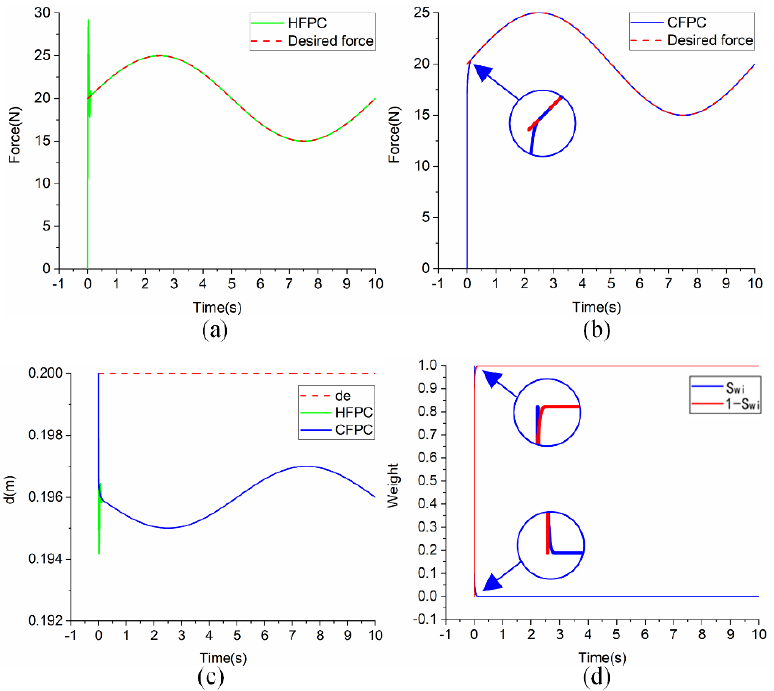
Figure 4. Simulations on plane surface. Force tracking using ( a ) the HFPC and ( b ) proposed CFPC methods. ( c ) Position tracking. ( d ) Weighted parameter s wi .